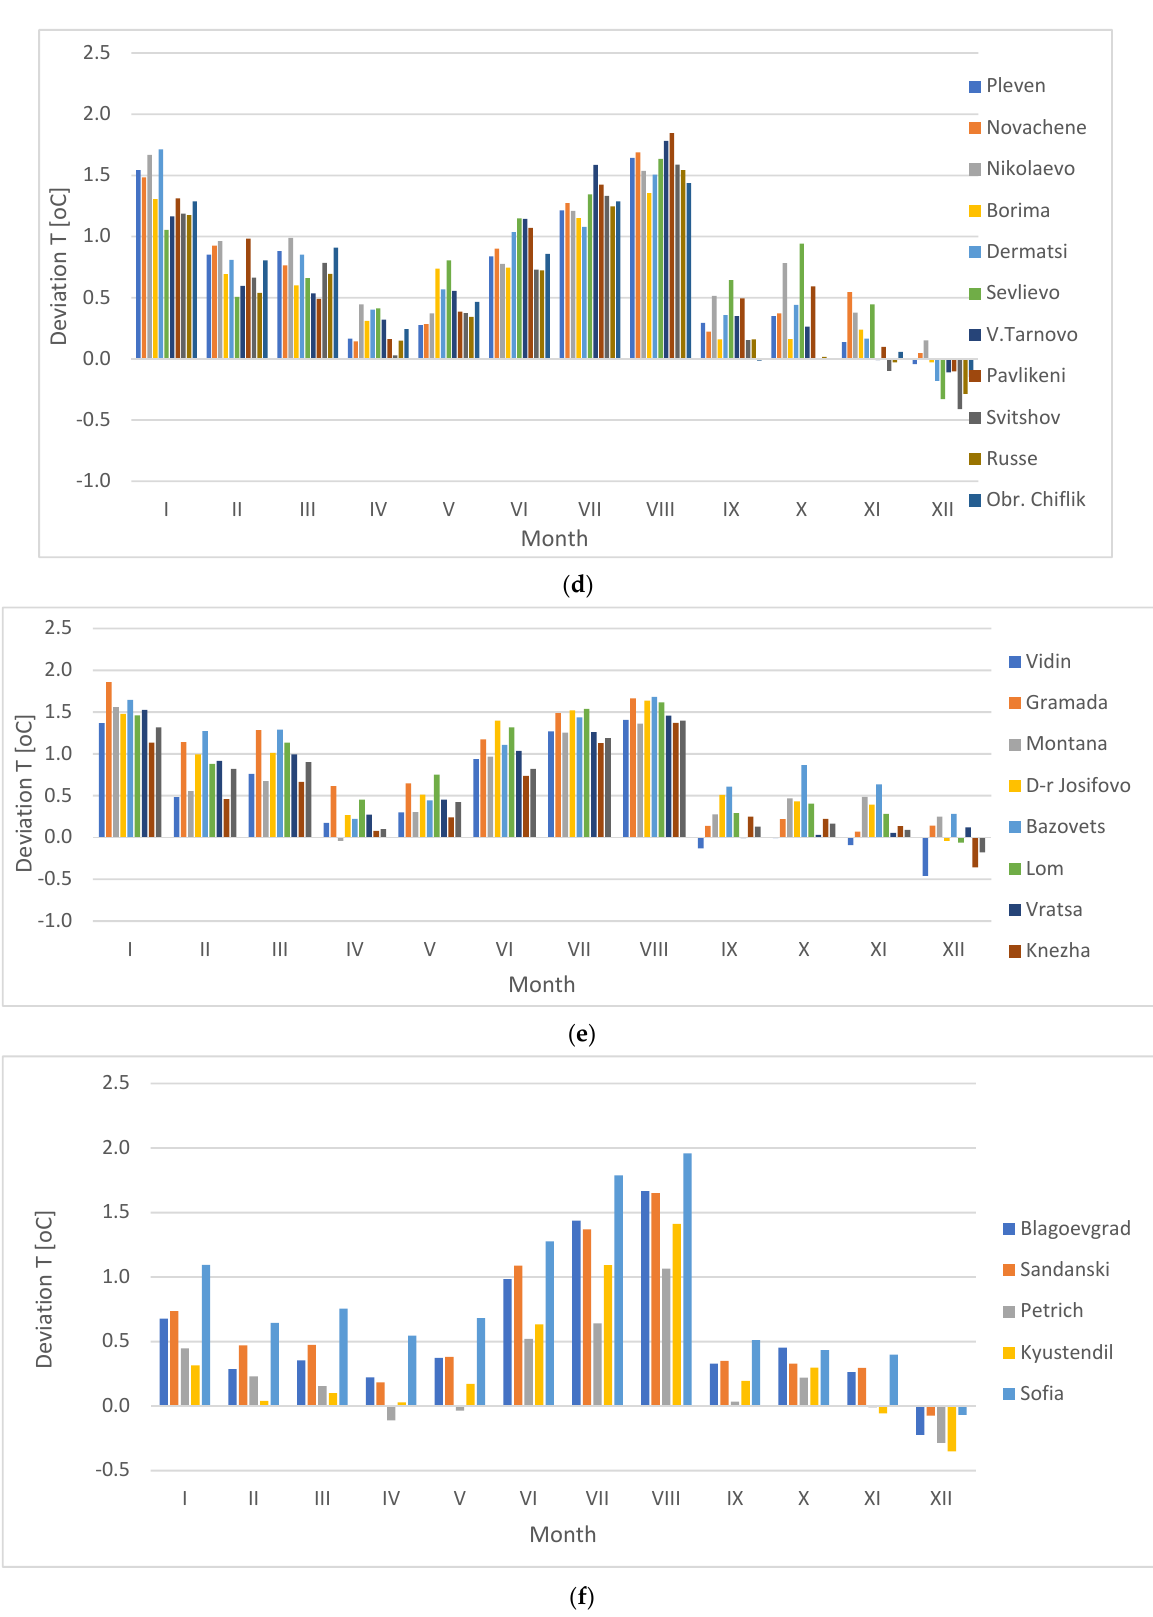
Figure 2. Deviations in average monthly temperatures for the period 1986–2015 in ( a ) northeast, ( b ) southeast, ( c ) central south, ( d ) central north, ( e ) northwest, and ( f ) southwestern Bulgaria compared to 1961–1990.